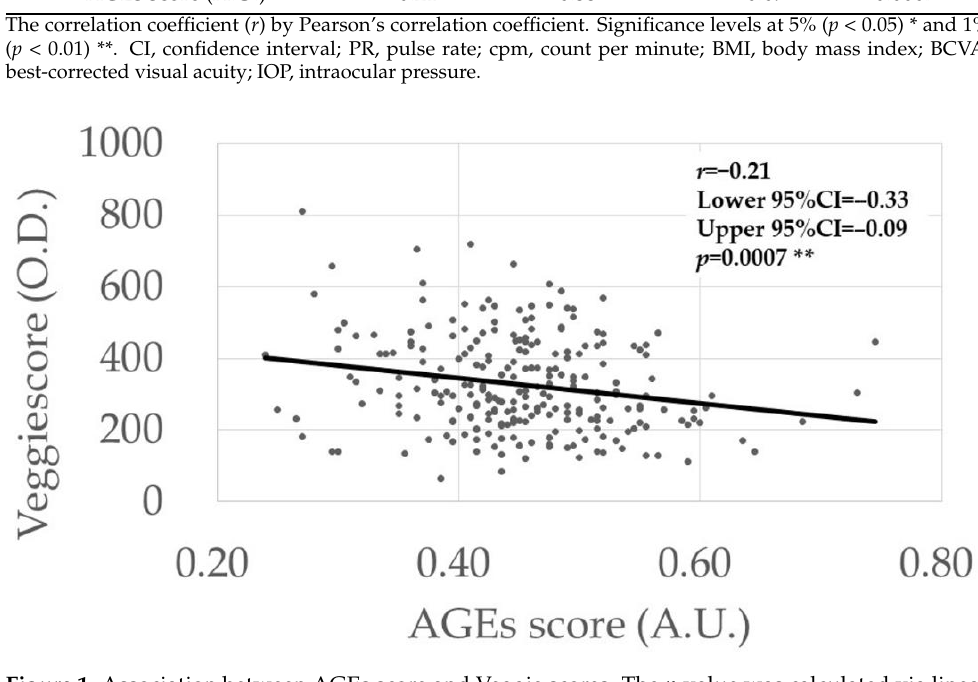
Figure 1. Association between AGEs score and Veggie scores. The p -value was calculated via linear regression analysis. ** Significance level at 1% ( p < 0.01).